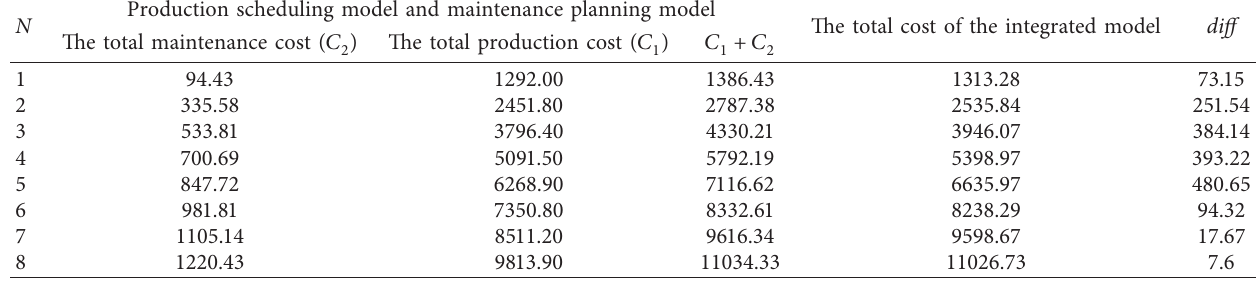
Table 7: The difference value between the independent model and integrated model ( U